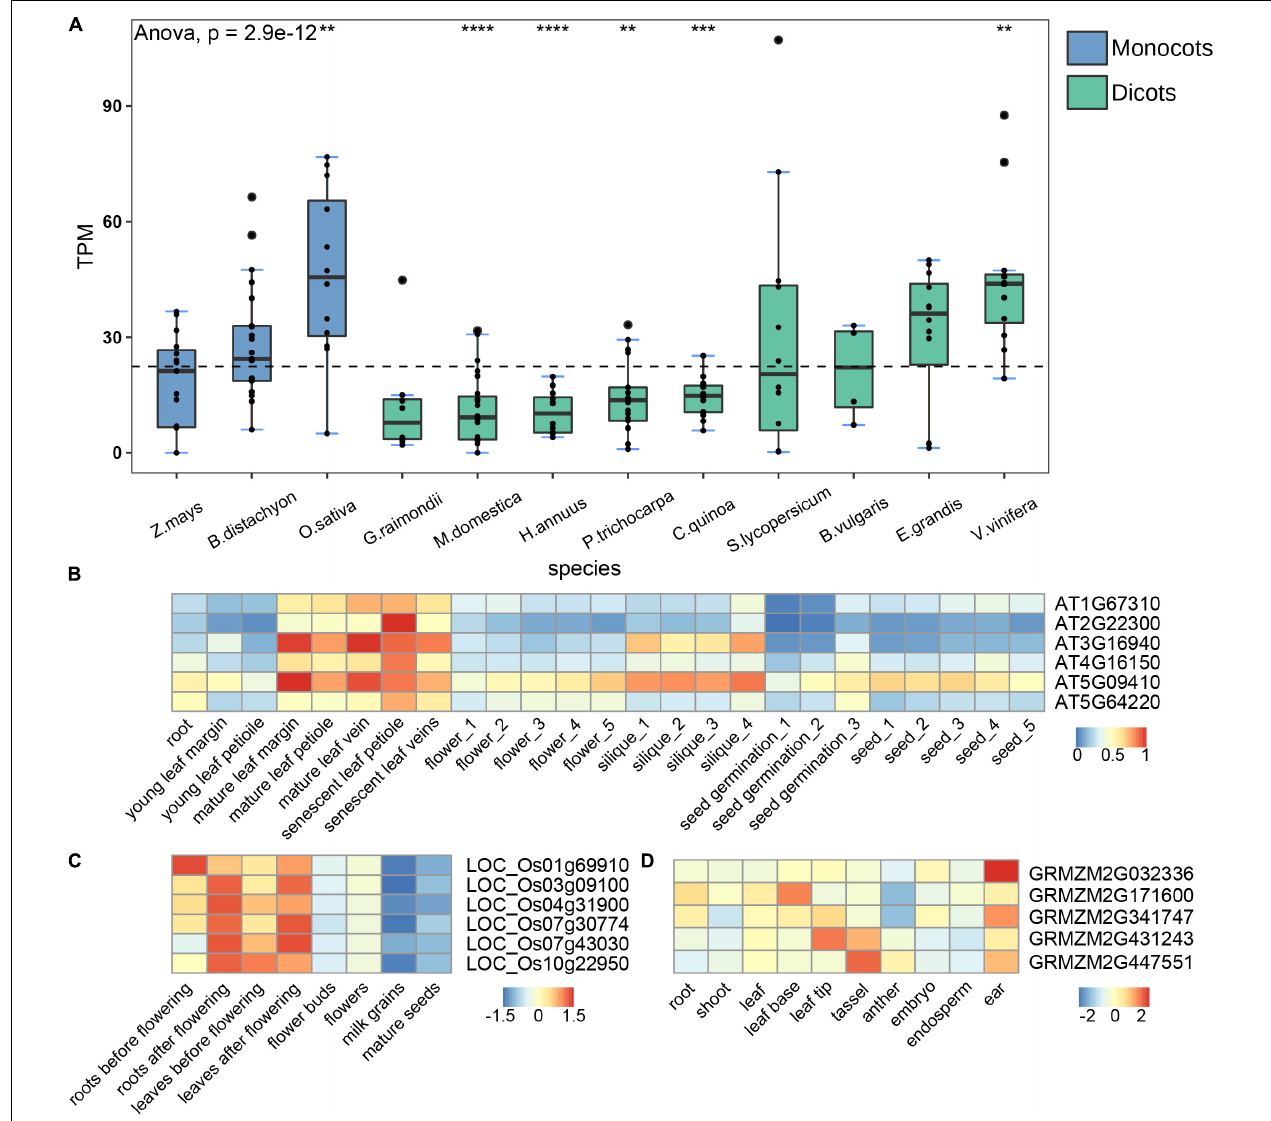
FIGURE 5 | Expression analysis of the CAMTA genes. (A) RNA-seq analysis of different species. The dotted line represents the average gene expression. Box plots indicate the first quartile, the median, and the third quartile. TPM indicates Transcripts Per Kilobase of exon model per Million mapped reads. (B–D) CAMTA expression in different tissues of A. thaliana , O. sativa , and Z. mays . The numbers behind the tissues represent different developmental stages. The symbols of “*”, “**”, “***”, and “****” represent the p -values are 0.05, 0.01, 0.001, and 0.0001, respectively.